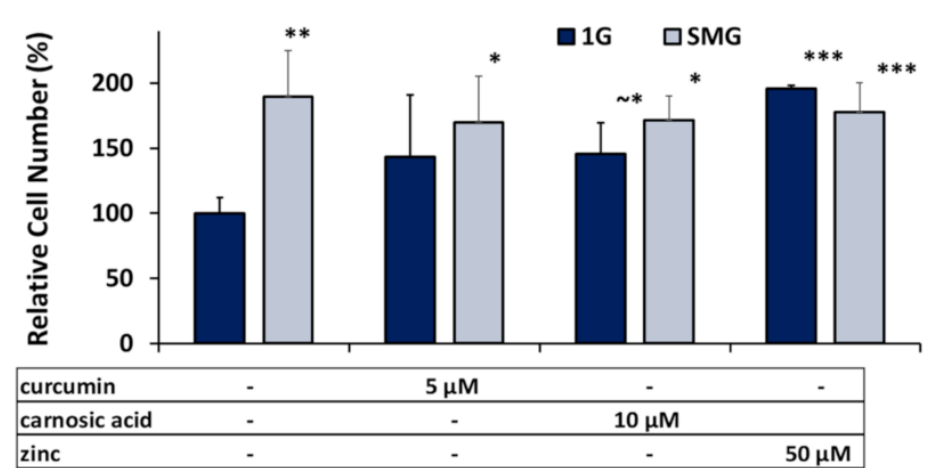
Figure 1. Effects of optimal nutraceutical concentrations on relative cell density per flask. Cell num- bers after 6 days’ DM cell culture in 1G or SMG were quantified using the PICO green fluorometric assay and normalized to the 1G controls. Error bars indicate standard deviations. (~*) p ≈ 0.05; (*) p < 0.05; (**) p < 0.01; (***) p < 0.001. The results reflect means ± SD from three